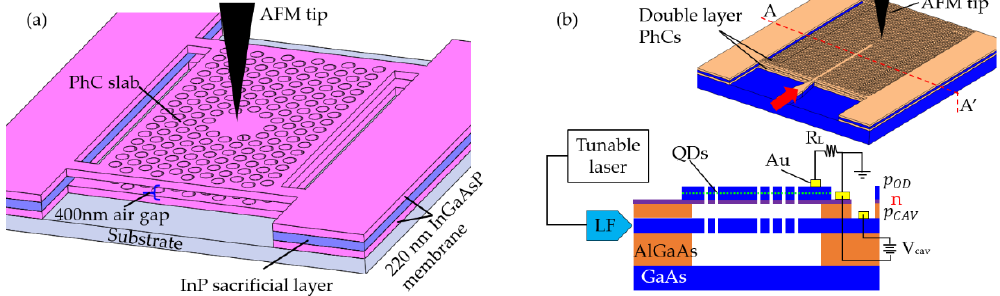
Figure 12. Schematics of the strain sensors: ( a ) double-layer PhC cavity using an atomic force microscope (AFM) tip contacting the center of microcavity to apply strain [12,102]; ( b ) displacement sensor using a double-membrane PhC slab integrated with electro-optical readout [10,103] .